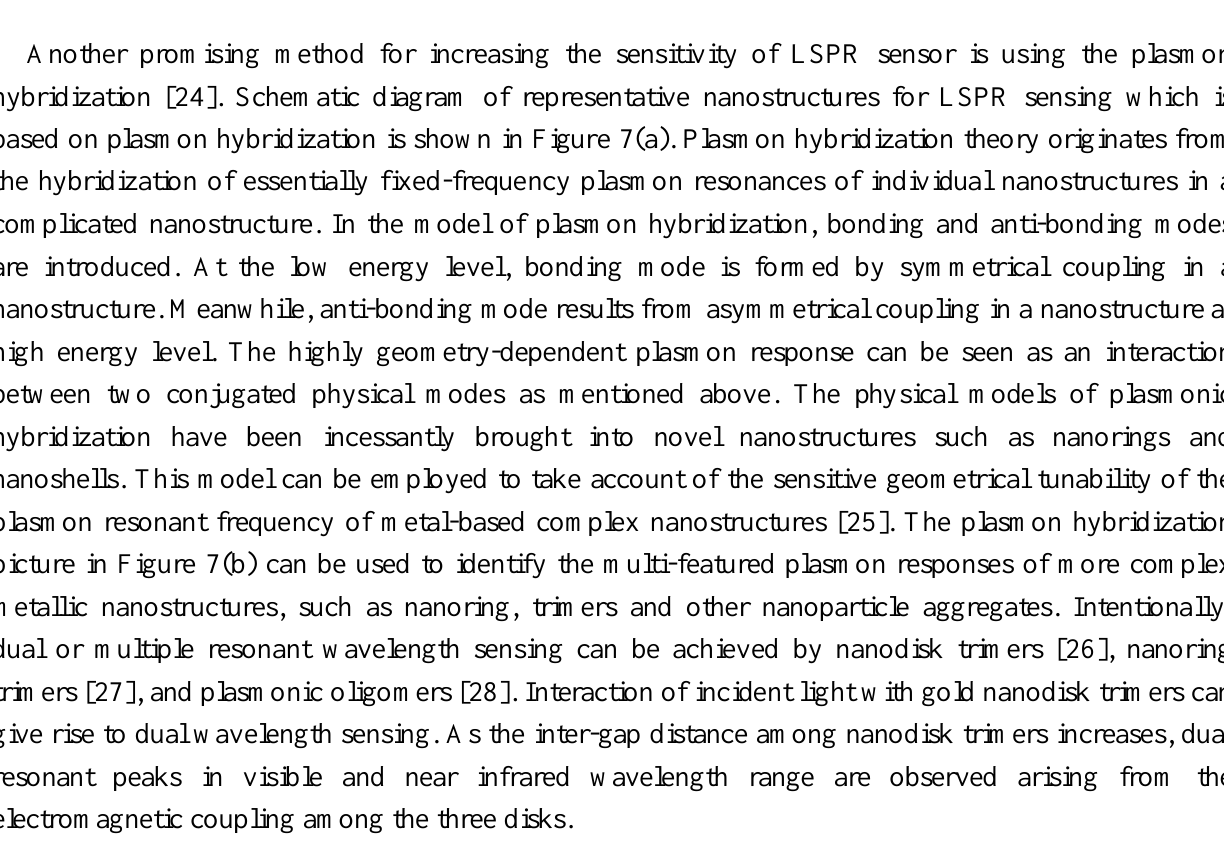
Figure 7. (a) Various nanostructure designs based on the plasmon hybridization and (b) simplified energy diagram for explaining the plasmon